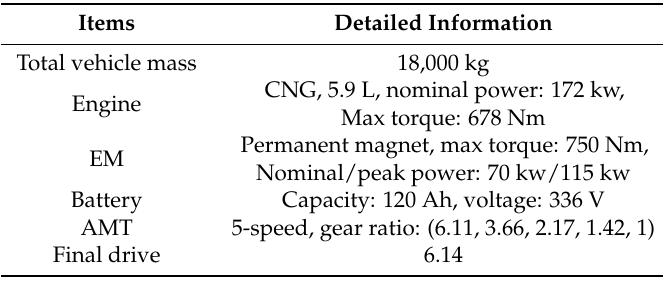
Table 1. Main parameters of the